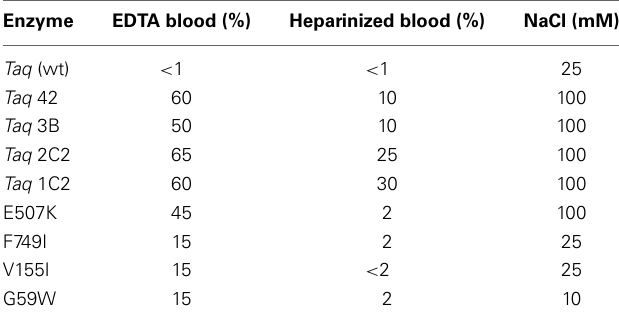
Table 3 | Resistance of Taq mutants to blood and